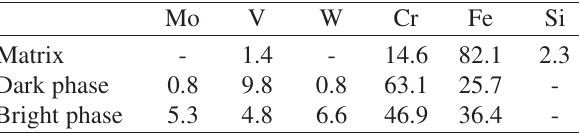
Table 4. Composition (% in mass) of phases in Fig. 6a.